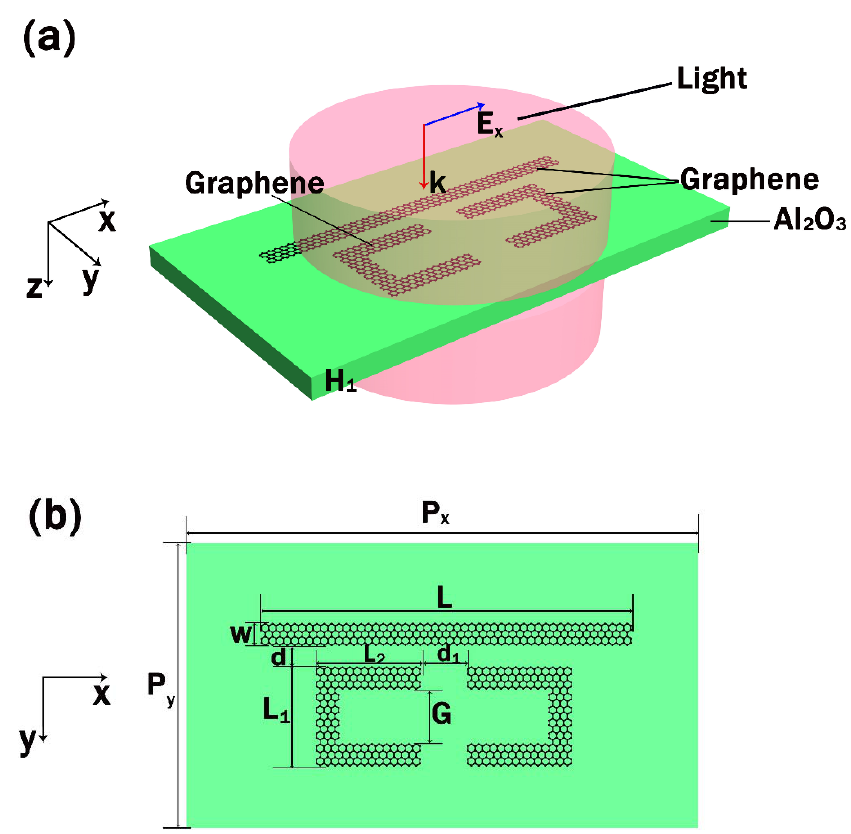
Figure 1. ( a ) Schematic of the unit cell of proposed graphene metasurface composed of graphene cut wire (CW) resonator and split-ring resonators (SRRs). ( b ) Top view of the unit cell with the geometrical parameter P x = 125 nm, P y = 66 nm, L = 85 nm, W = 7 nm, d = 6 nm, L 1 == 29 nm, L 2 = 25 nm, d 1 = 5 nm, G = 19 nm and the thickness of the substrate is H 1 = 40